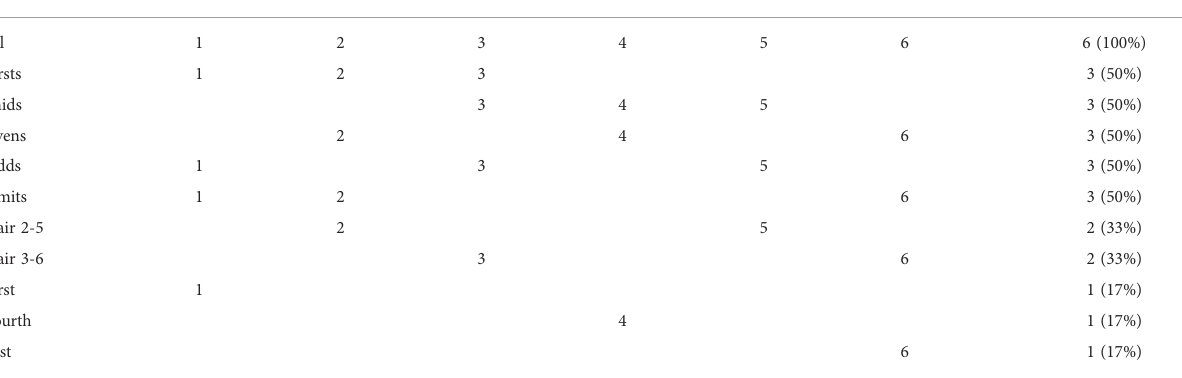
TABLE 2 Simulated